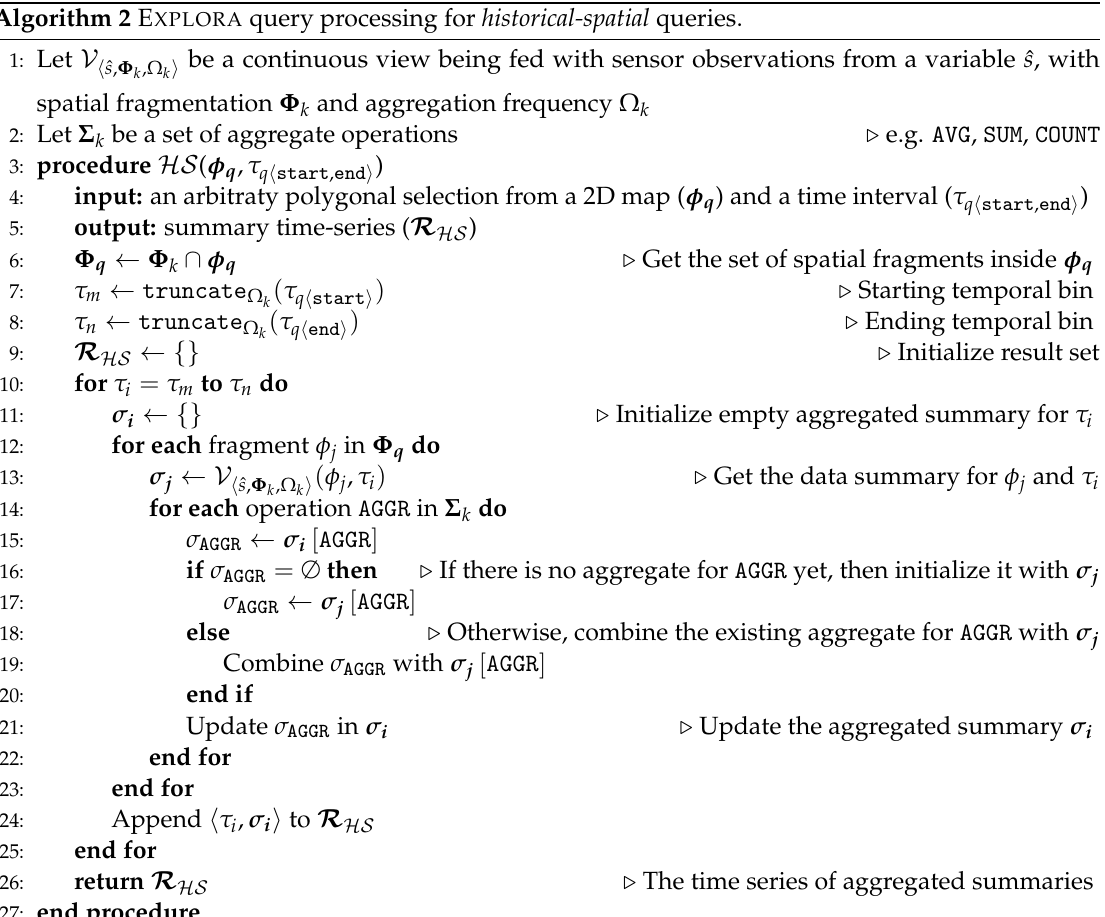
Algorithm 2 E XPLORA query processing for historical-spatial queries. spatial fragmentation Φ k and aggregation frequency Ω